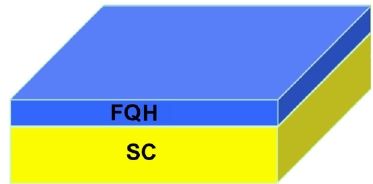
FIG. 1. Schematic setup of a fractional topological super- conductor. This state of matter can be achieved by inducing a superconducting order parameter into a fractional quantum Hall bar or a fractional Chern insulator through the proximity